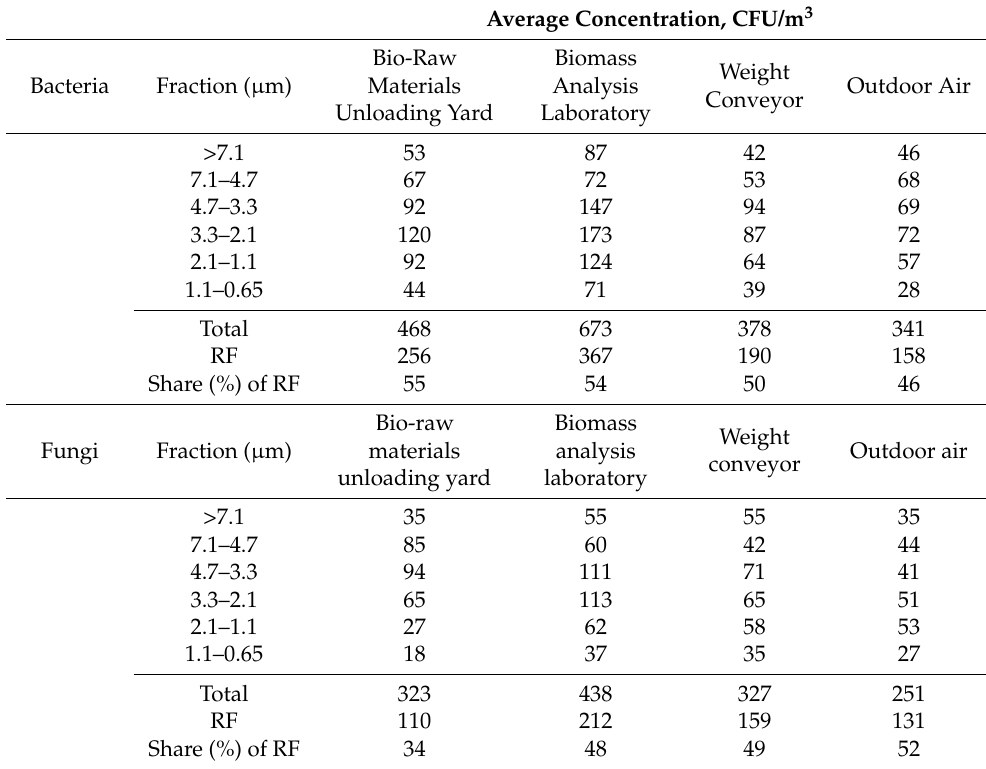
Table 3. The average concentration and size distribution, CFU/m 3 of micro-organism colony-forming units per cubic metre.